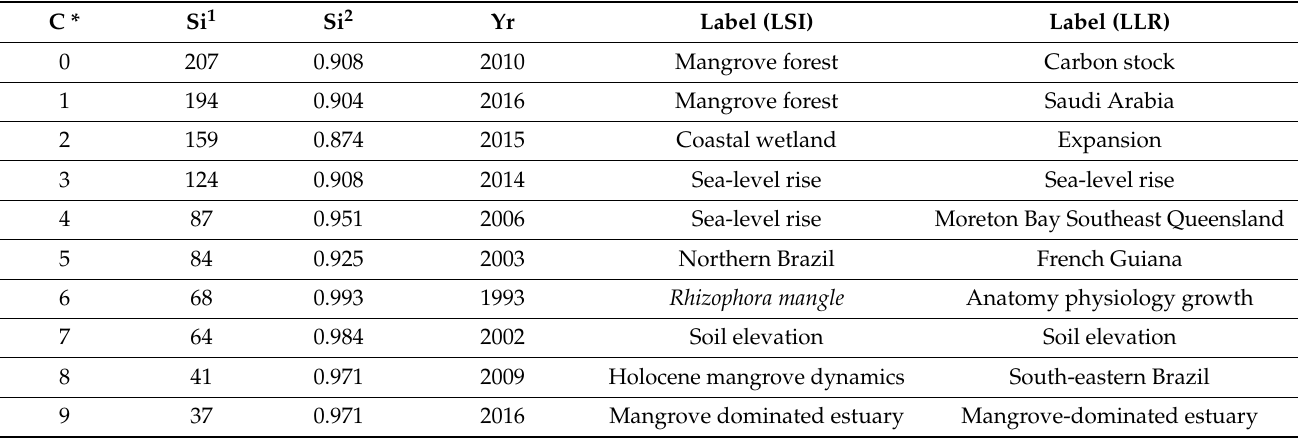
Table 3. Top-ranked clusters and labels produced by LSI and LLR on mangrove forest-related studies.